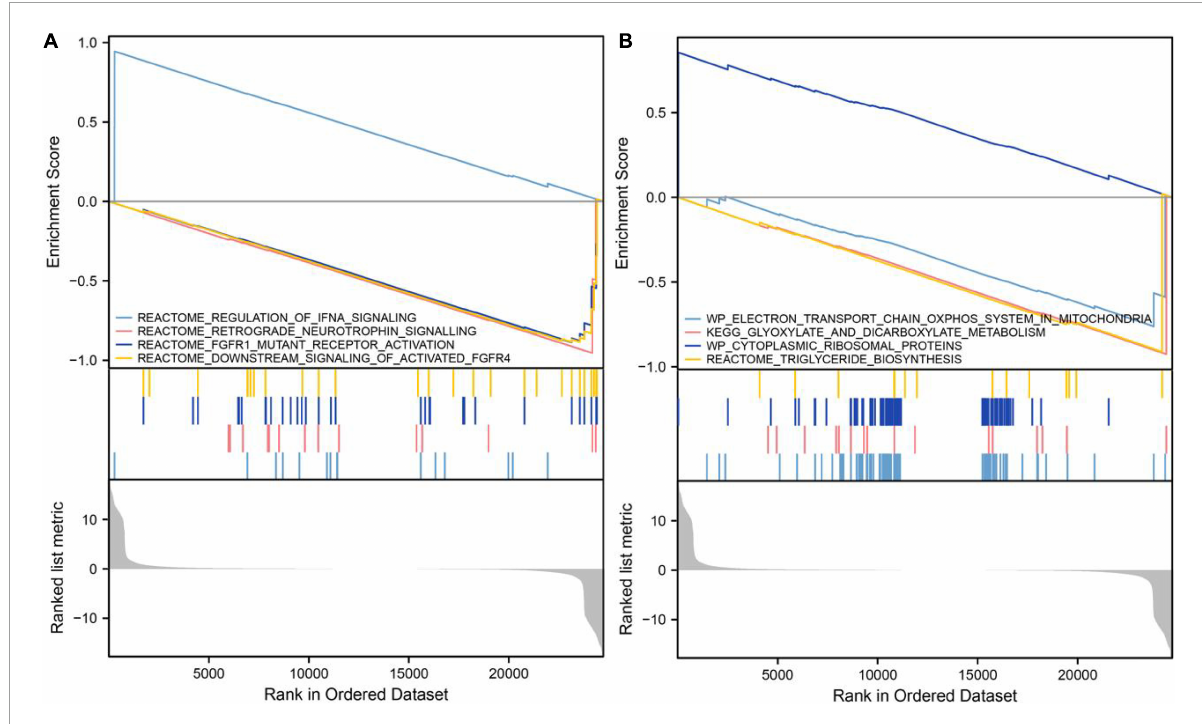
FIGURE5 Gene set enrichment analysis of VCAM1. (A) Upregulation of VCAM1 was accompanied by inhibition of pathways associated with promotion of cell growth. (B) Upregulation of VCAM1 was accompanied by inhibition of energy and metabolism-related